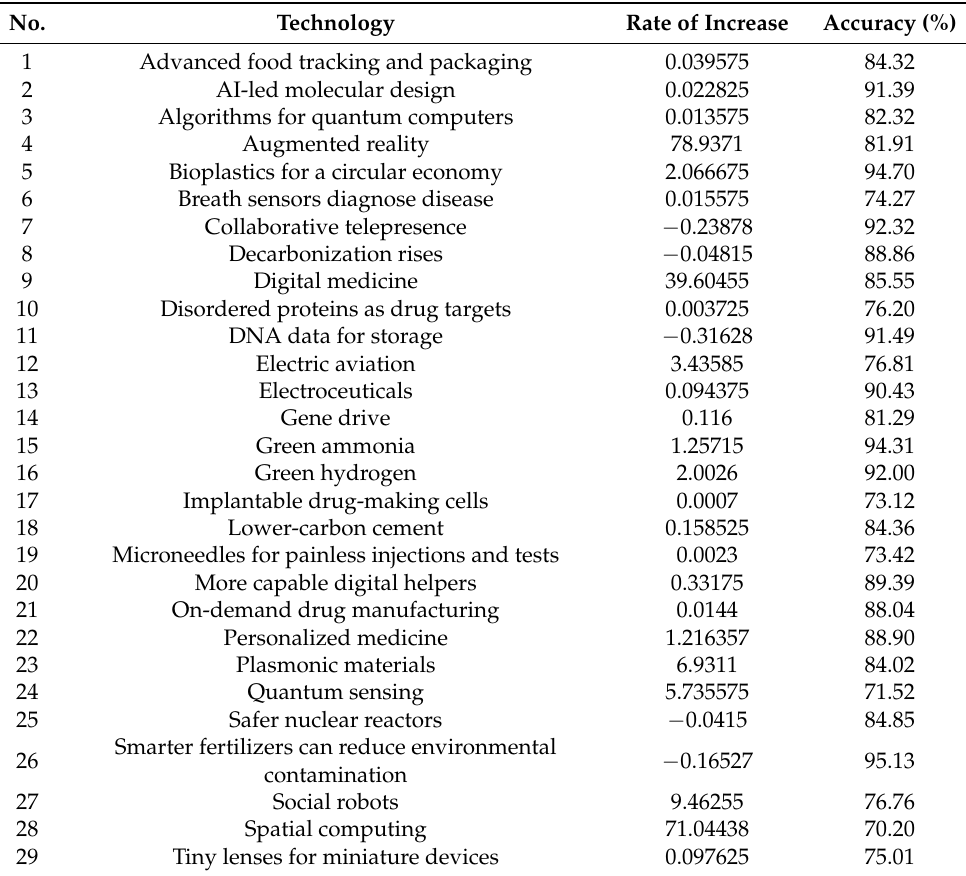
Table 5. Rate of increase and prediction accuracy of the predicted number of Science Citation Index (SCI) papers by